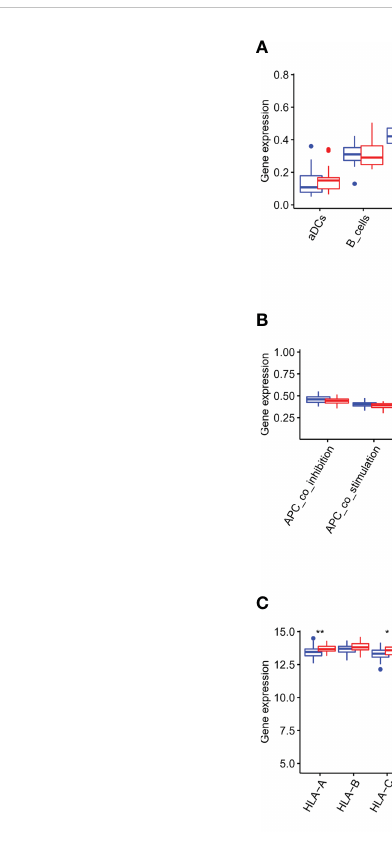
FIGURE 8 Characteristics of the immune microenvironment in two different m6A subtypes of OA. (A) Differences in the in fi ltrating immunocytes in the immune microenvironment of distinct m6A subtypes in OA. (B) Differences in the immune pathways in the immune microenvironment of distinct m6A subtypes in OA. (C) Differences in the HLA genes expression in the immune microenvironment of distinct m6A subtypes in OA. *p < 0.05, and **p <